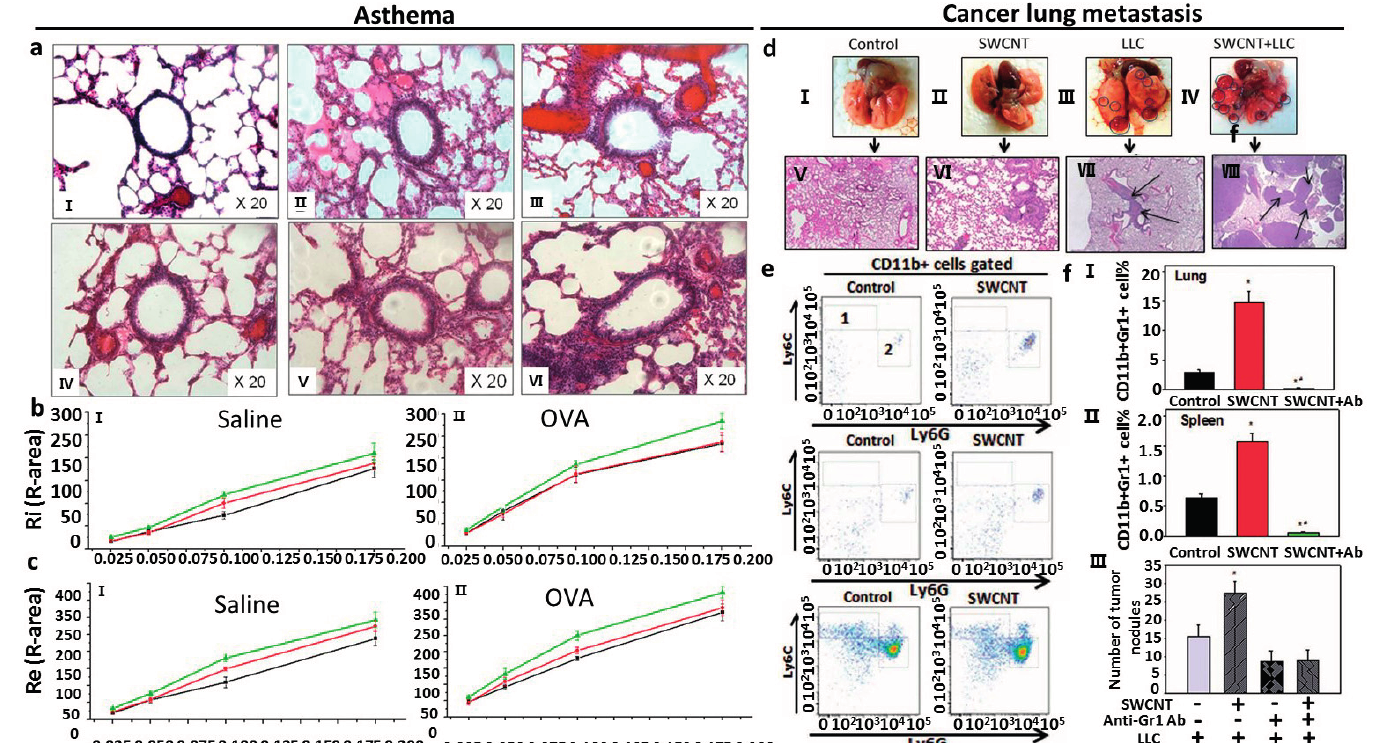
Figure 2. ( a ) Lung section of mice from saline treatment plus 0 mg/mL nano-SiO 2 exposure (I), saline treatment plus 40 mg/mL nano-SiO 2 exposure (II), saline treatment plus 80 mg/mL nano-SiO 2 exposure (III), OVA treatment plus 0 mg/ml nano-SiO 2 exposure (IV), OVA treatment plus 40 mg/mL nano-SiO 2 exposure (V), OVA treatment plus 80 mg/mL nano-SiO 2 exposure (VI) [29]; ( b ) Ri of saline groups (I) and OVA groups (II) [29]; ( c ) Re of saline groups (I) and OVA groups (II) [29]; ( d ) Visualization of the lungs with tumor nodules (cricled) from different groups (I–IV) and histological images of the lung sections (×100) with micrometastases (arrows) from different groups (V–VII) [35]; ( e ) FACS analysis of monocytic CD11b + Ly6G neg Ly6C high (area 1) and granulocytic CD11b + Ly6G + Ly6C low/neg (area 2) MDSC in the lymphoid tissues and lungs in tumor-free mice 48 h after SWCNT (80 μ g/mouse) or PBS (control group) pharyngeal aspiration [35]; ( f ) Analysis of CD11b + Gr-1 + MDSC in tumor-free C57BL6/J mice 48 h after SWCNT (80 μ g/mouse) pharyngeal aspiration. * p < 0.05 versus Control group; ** p < 0.0025 versus Control group (One-way ANOVA)